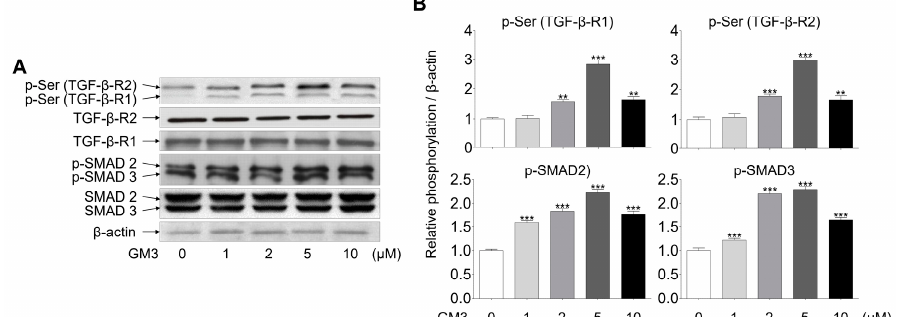
Figure 4. E ff ect of GM3 on TGF- β receptor and SMAD 2 / 3 activation during the chondrogenic